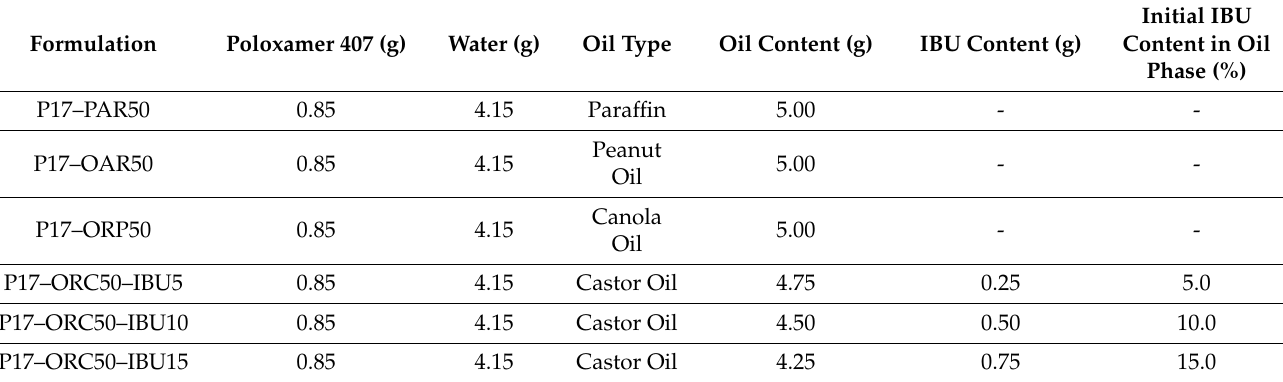
Table 2. Detailed composition of formulations. Quantities per 10.0 g of the sample weight.